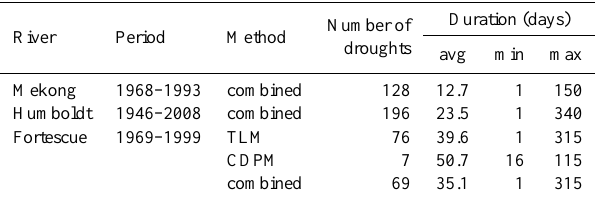
Table A1. Drought characteristics for the additional rivers identified with the drought analysis methods.